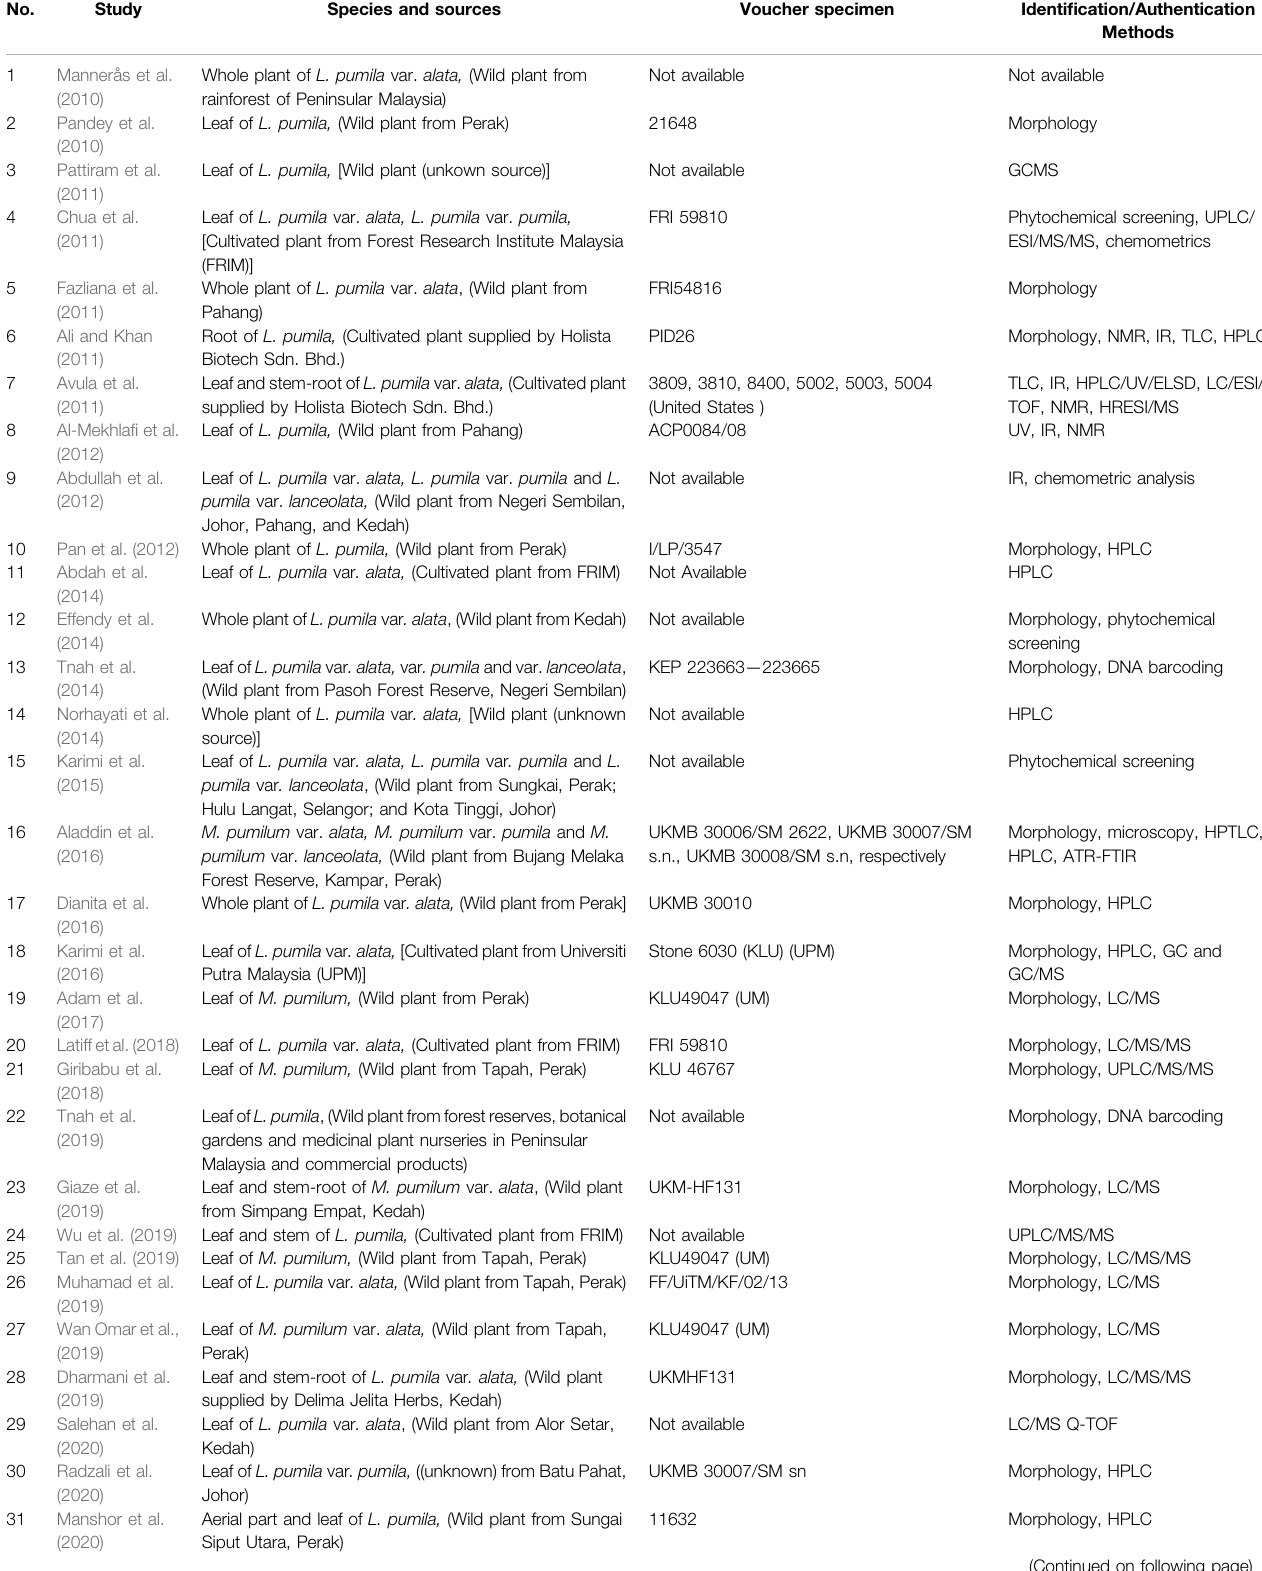
TABLE 1 | Authentication and identi fi cation methods of Marantodes pumilum botanical drug substances and commercial